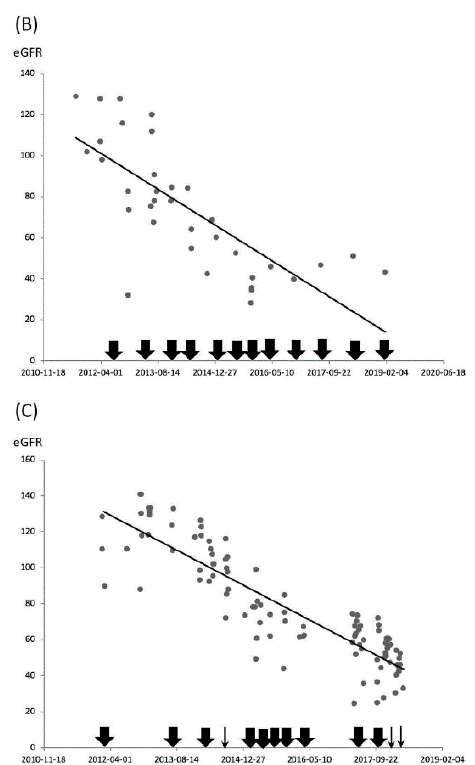
Figure 2. Changes in renal function in three patients with ketamine-associated hydronephrosis. There